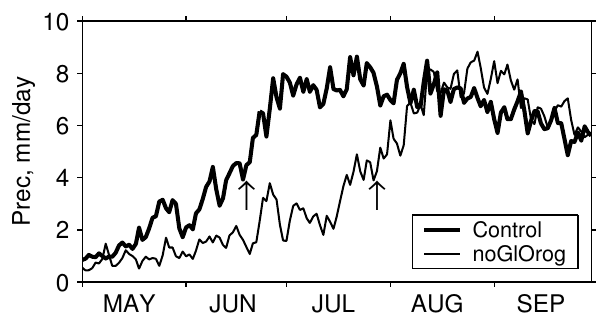
Fig. 2. Daily rainfall variation over the Indian region from the con- trol and noGlOrog simulations in mmday − 1 . Monsoon onset dates in both simulations (obtained according the definition of onset used in this study, see Sect. 5 of text for details) are indicated by arrows in the corresponding curves. The onset of monsoon over this re- gion was delayed by 39 days when orography was removed from the entire